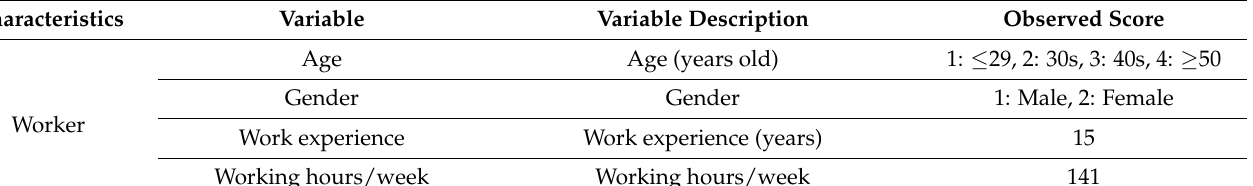
Table 1. Research variables of this